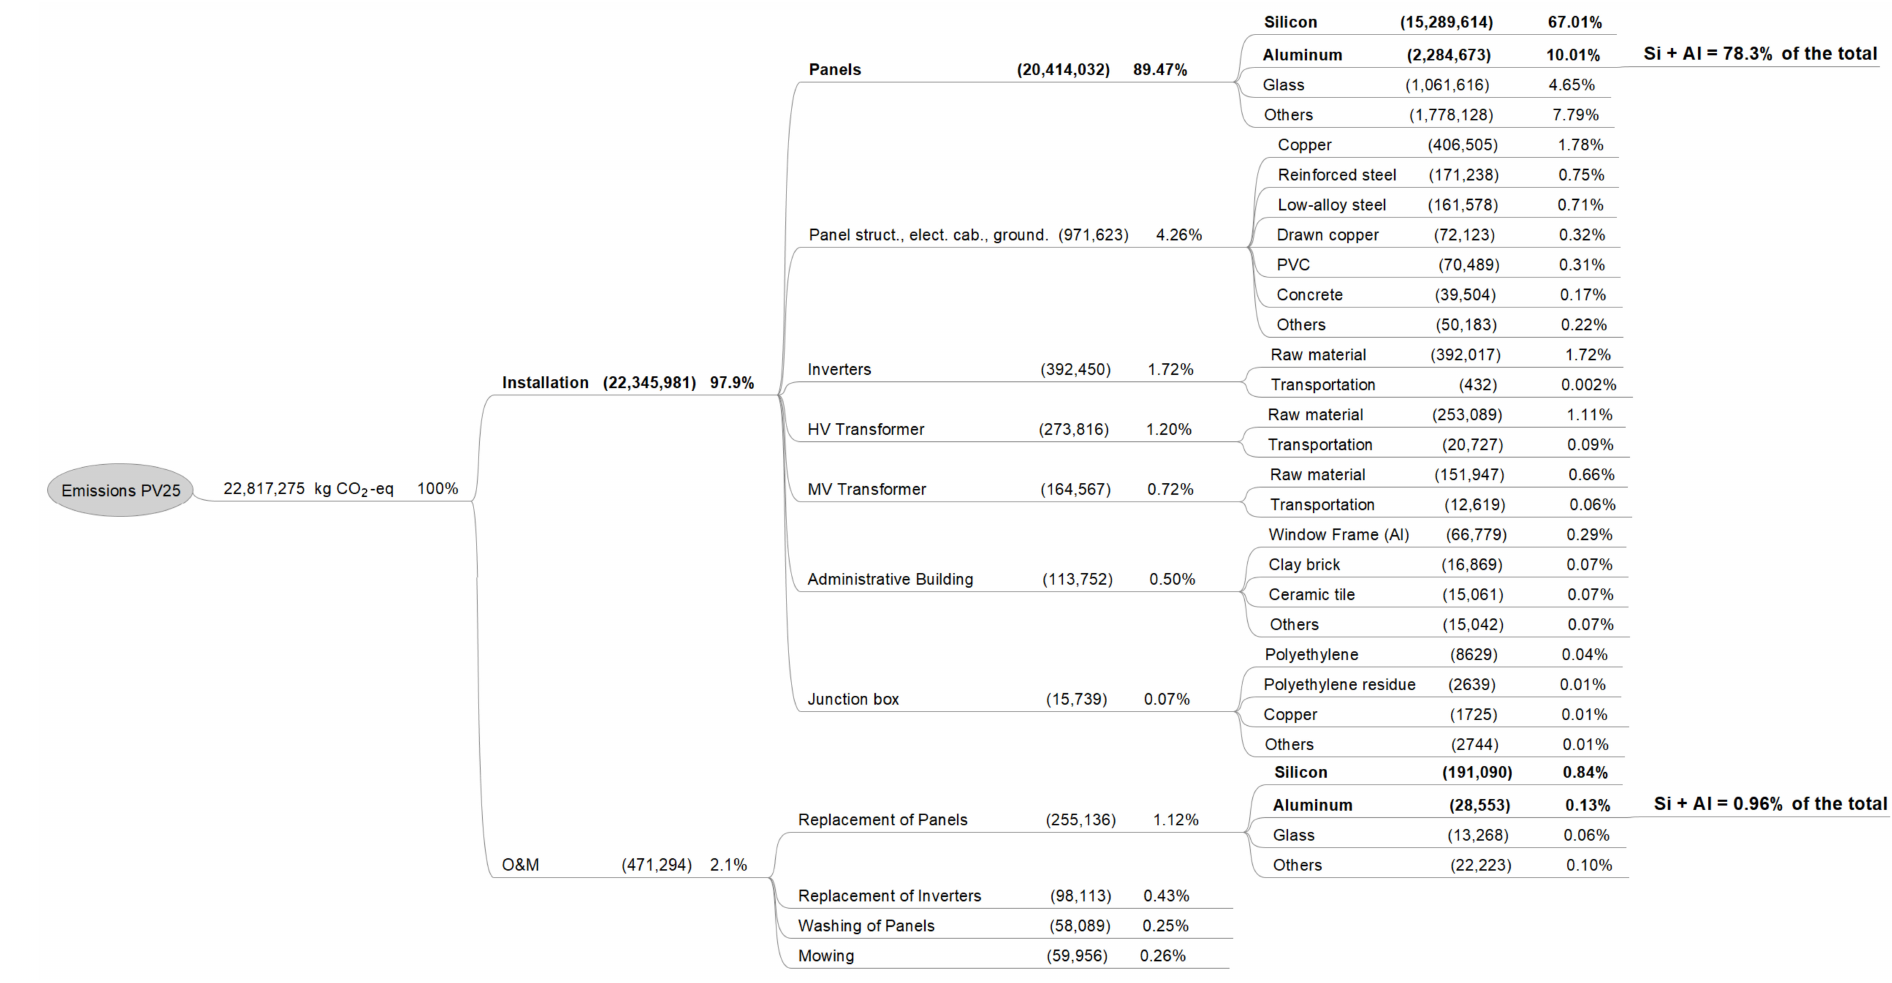
Figure 5. Total emissions for the photovoltaic solar generation